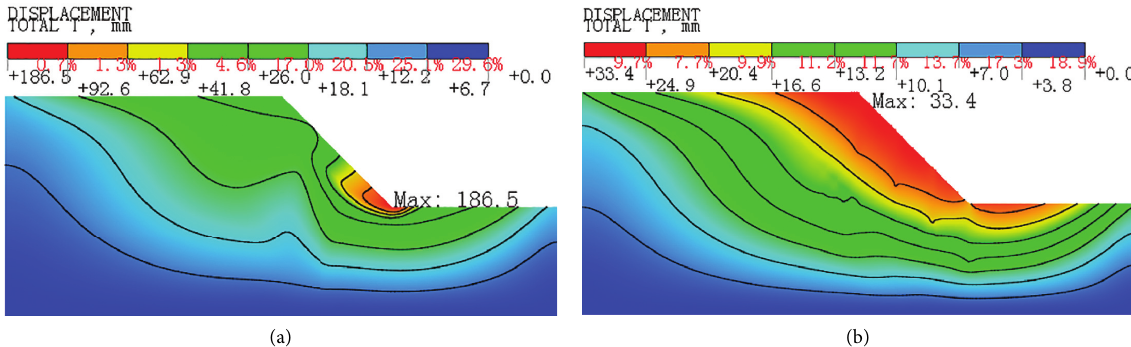
Figure 5: Displacement field of the original slope and ecological slope after 24h of rainfall. (a) Original slope. (b) Ecological slope protection by composite vegetation with geogrid reinforcement.